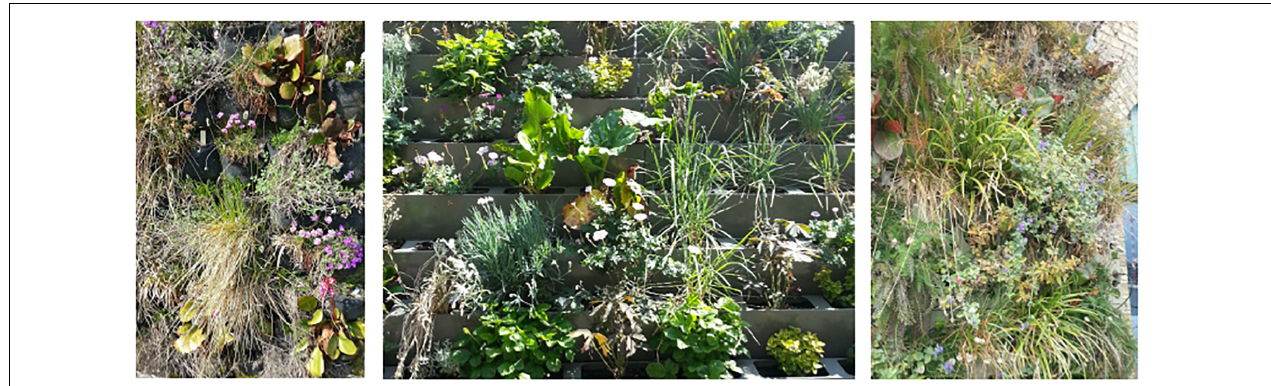
FIGURE 1 | Capillary mat pocket living wall system (Left: wall type 1, “pockets”); container living wall system (Centre: wall type 3, “containers”) and mineral wool living wall system (Right: wall type 2, “panel system”) growing in southern Sweden used to determine colour and visual plant performance of plants. (Photograph Ann-Mari Fransson).